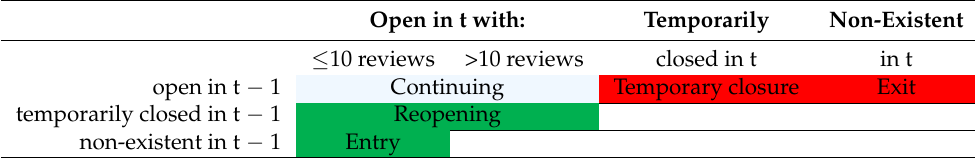
Table 1. Business openings (entries and reopenings) and closures (exits and temporary closures). Open in t